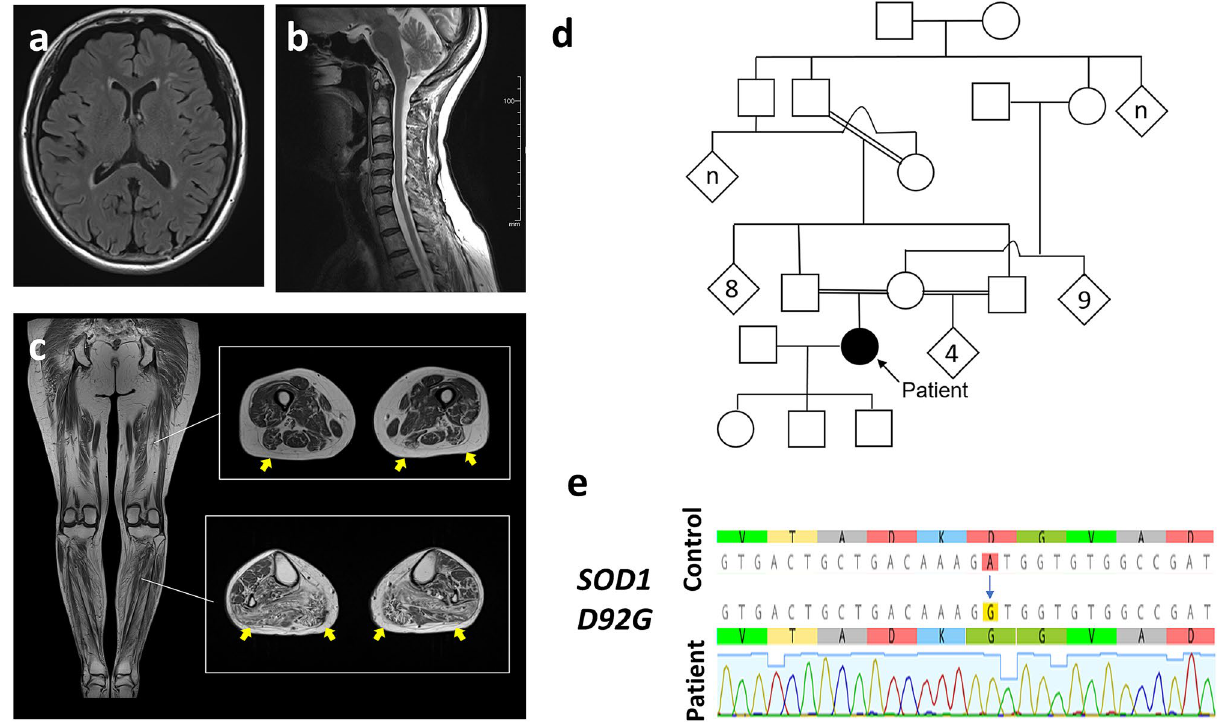
Figure 1. Clinical features of the ALS patient carrying a homozygous D92G mutation of SOD1 . ( a – c ) Magnetic resonance imaging (MRI) of the brain, spinal cord, and lower limbs. There are no abnormalities on MRI of the brain ( a ) and spinal cord ( b ). MRI of the lower limbs shows apparent muscle atrophy and fatty change predominantly in the calves ( c , yellow arrows). ( d ) The family history shows repeated